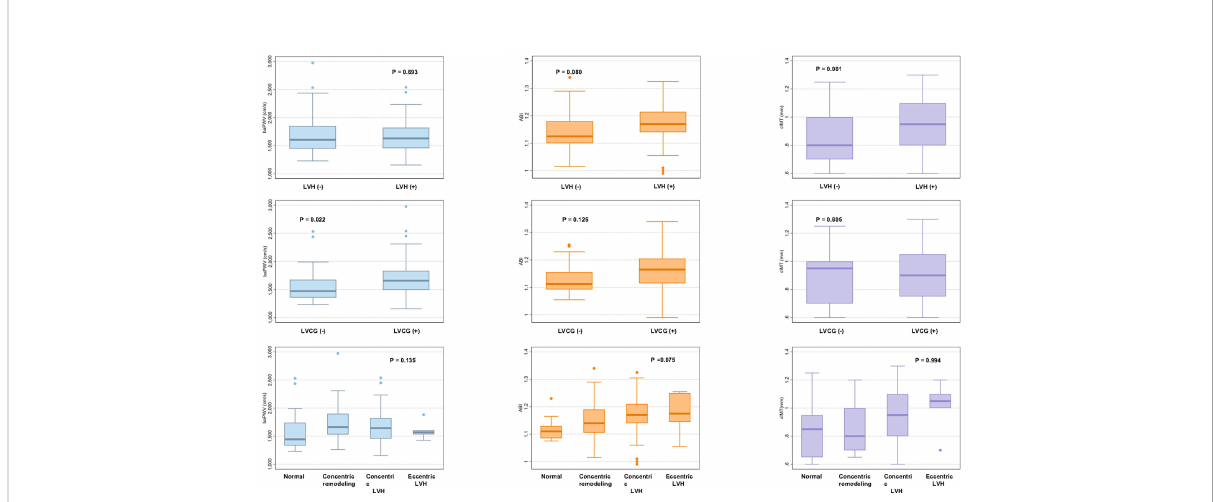
FIGURE 2 Box plots showing brachial – ankle pulse wave velocity, ankle – brachial index, and carotid intima-media thickness by left ventricular geometry patterns. BaPWV, ABI and cIMT values are shown as box plots with the median and interquartile range. BaPWV, brachial – ankle pulse wave velocity; ABI, ankle – brachial index; cIMT, carotid intima-media thickness; LVH, left ventricular hypertrophy; LVCG, left ventricular concentric geometry.